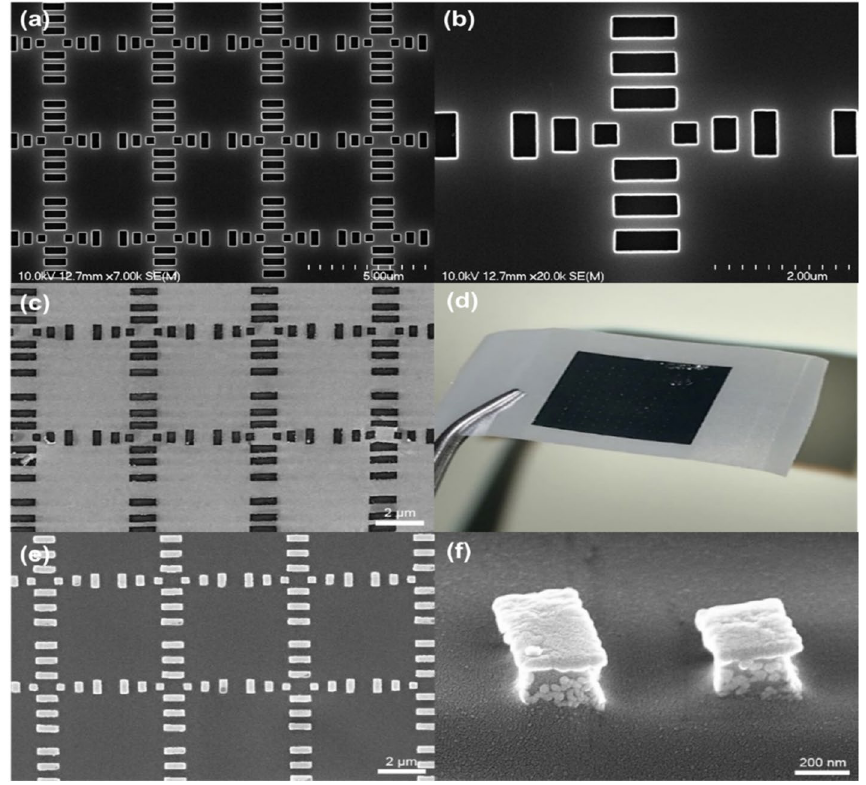
Fig. 4 a, b SEM image of the Si mold. c SEM image of adhesive tape. As shown in ( c, d ), Ag was peeled